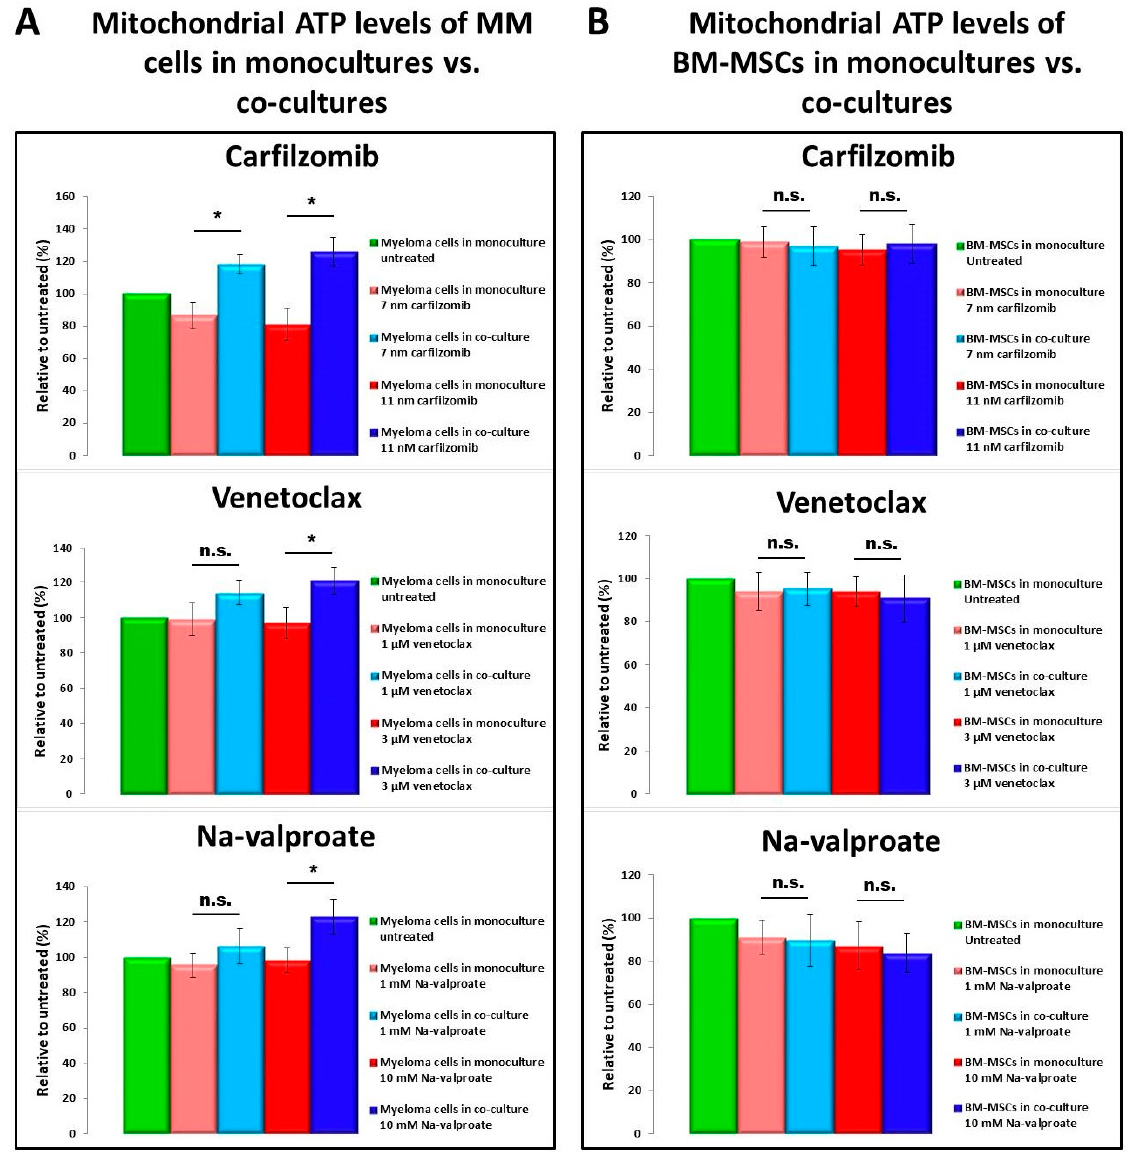
Figure 5. Mitochondrial ATP levels in MMs and BM-MSCs. BM-MSCs ( B ) or MMs ( A ) were plated in monocultures or in co-cultures and incubated for 24 h in the presence or absence of various drugs. After washing, cells were labeled with BioTracker ATP-Red for 15 min at 37 °C. Finally, after subsequent washing, ATP levels were analyzed by flow cytometry within the CD38 + MM cell population ( A ) or within the CD146 + BM-MSC population ( B ) using anti-CD38 Alexa Fluor 488 or anti-CD146 Alexa Fluor 488 monoclonal antibodies, respectively. The values are presented as mean ± standard deviation, p values < 0.05 were considered significant ( * ) while p values > 0.05 were considered non-significant (n.s.). The results are representative of three independent experiments for one patient.